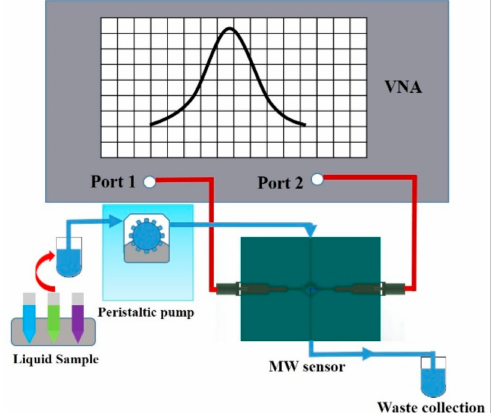
Figure 6. Schematic diagram of the experimental setup. The system is mainly composed of the VNA, peristaltic pump, waste collection and microwave sensor module.